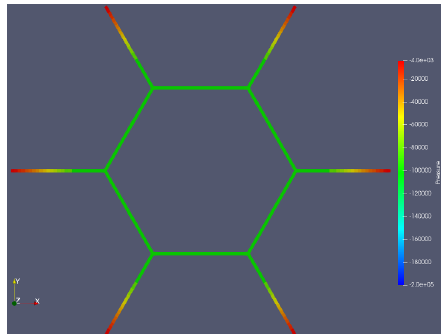
Figure 3: Pressure field for 1-phase fluid (left) and 2-phase fluid (right) at t = 0.013 s